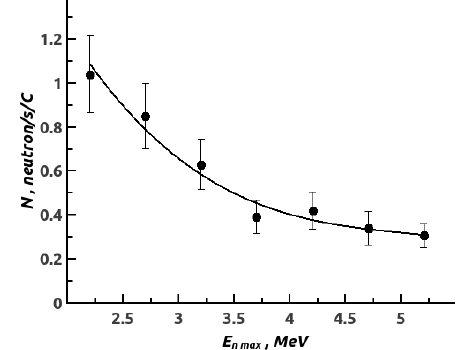
Fig. 7. The neutron counting rate in the 10 B-detector per sec per coulomb of the accelerator beam charge versus maximum energy of